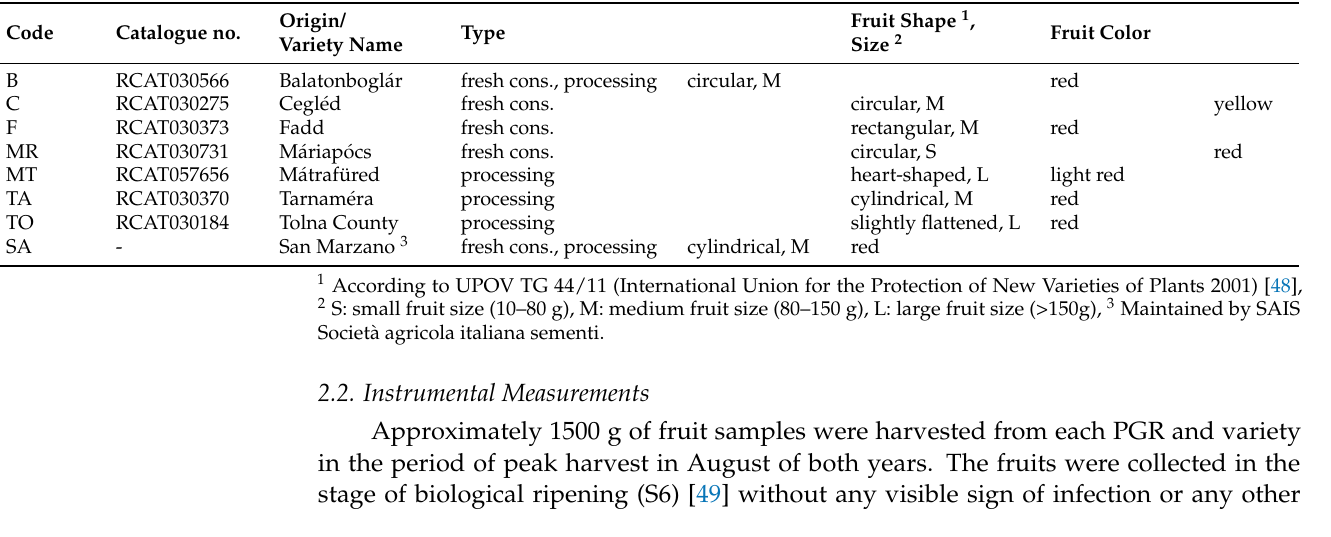
Table 2. Characteristics of investigated PGRs and the control variety San